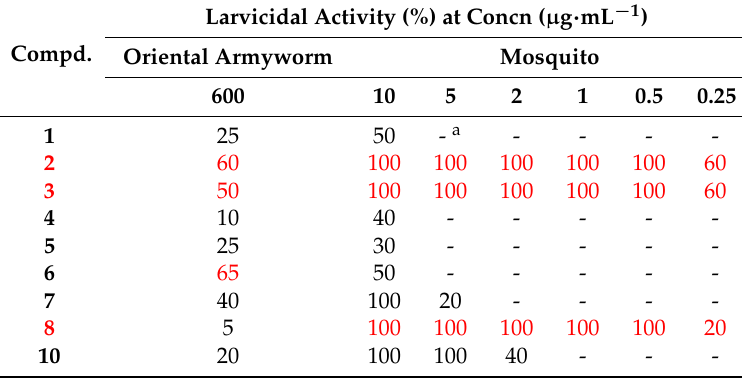
Table 1. Larvacidal activities against oriental armyworm and mosquito of compounds 1 – 8 , 10 .